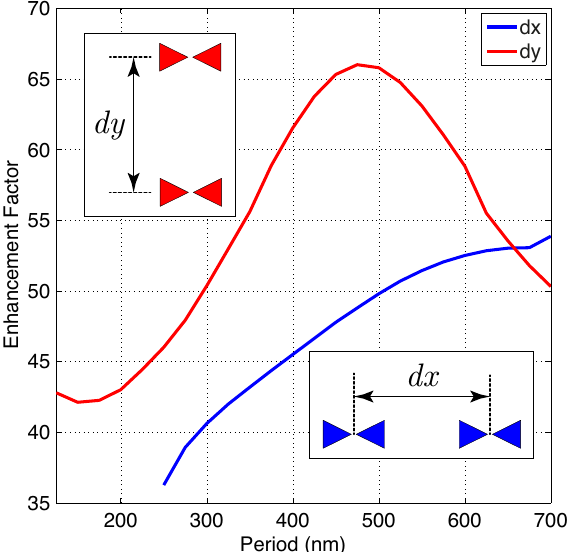
Figure 2: Power enhancement factor at the gap of an Ag bowtie nanoantenna, when another identical nanoantenna is placed at different nearby